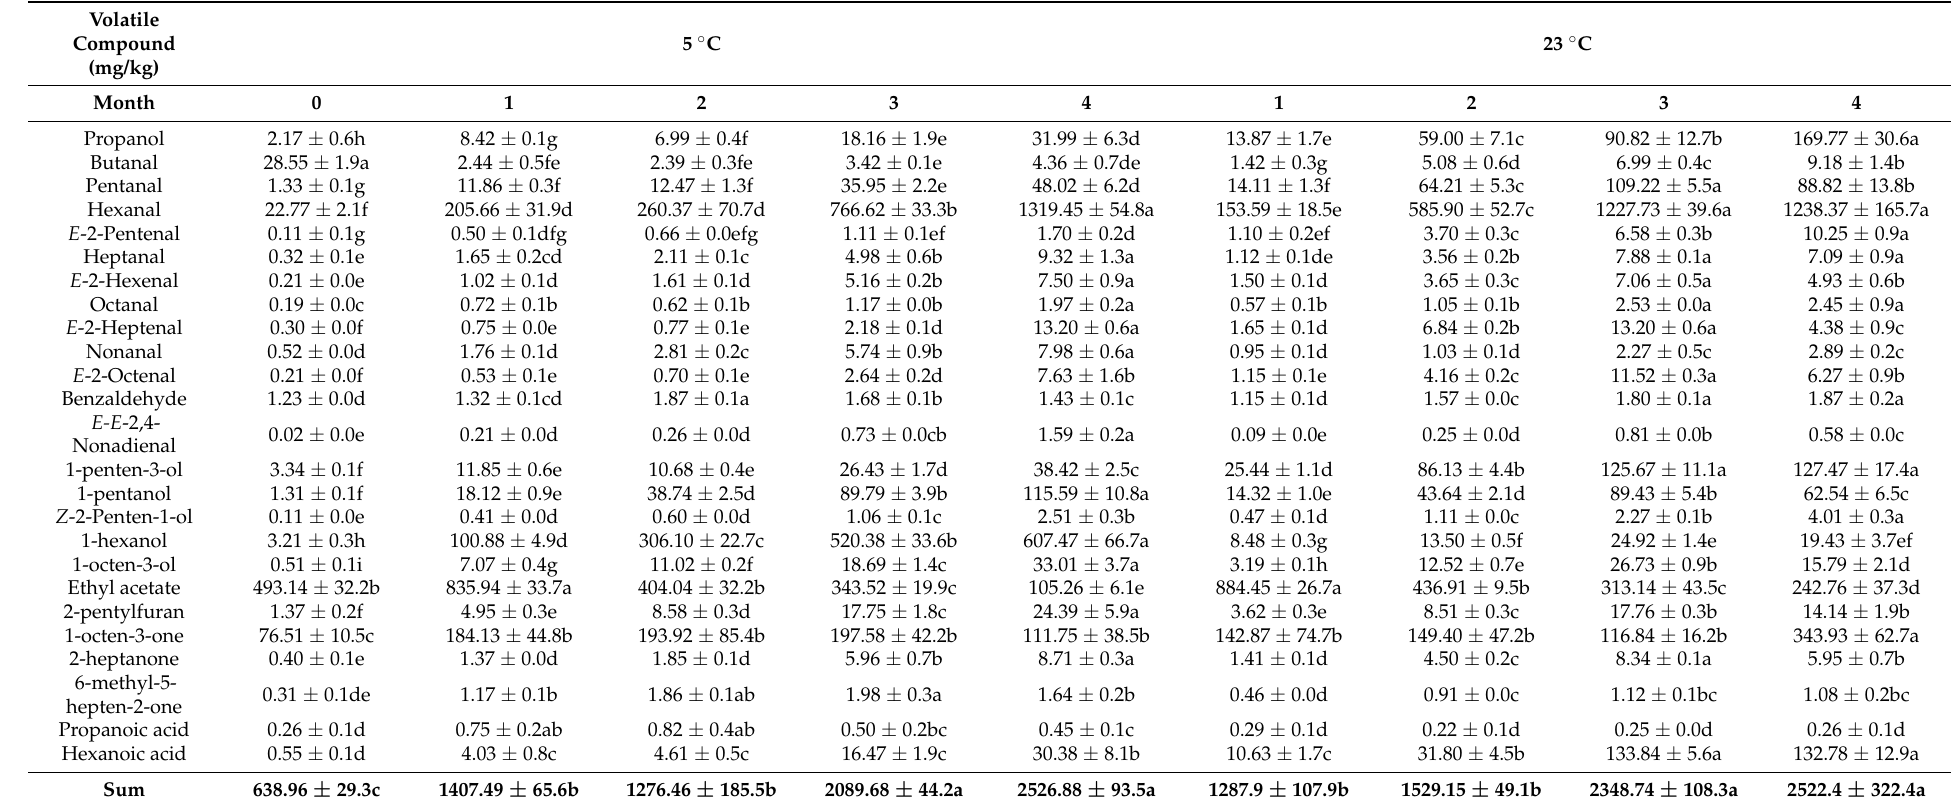
Table 4. Volatile changes in Howard kernels during